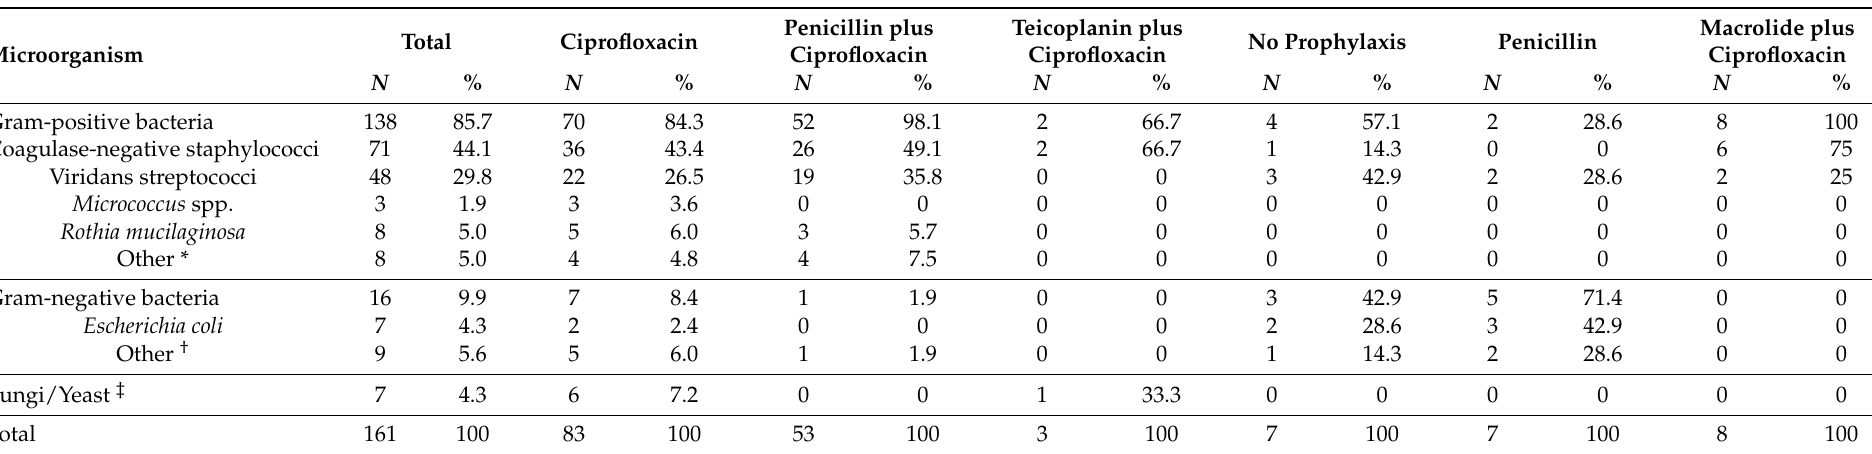
Table 3. Microorganisms detected in blood cultures of febrile neutropenic pediatric acute myeloid leukemia patients. Total Microorganism